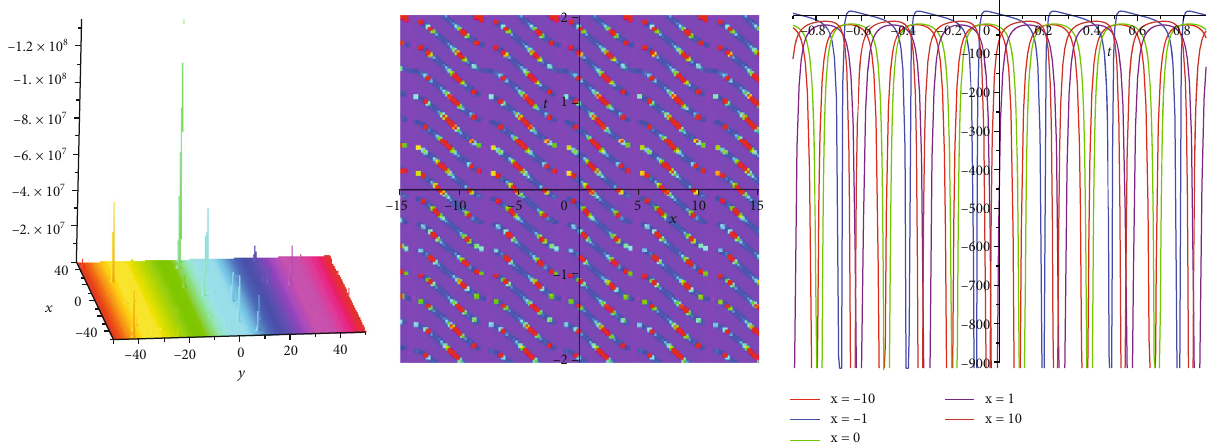
Þ (3D plot, density plot, and 2D plot t ), 1